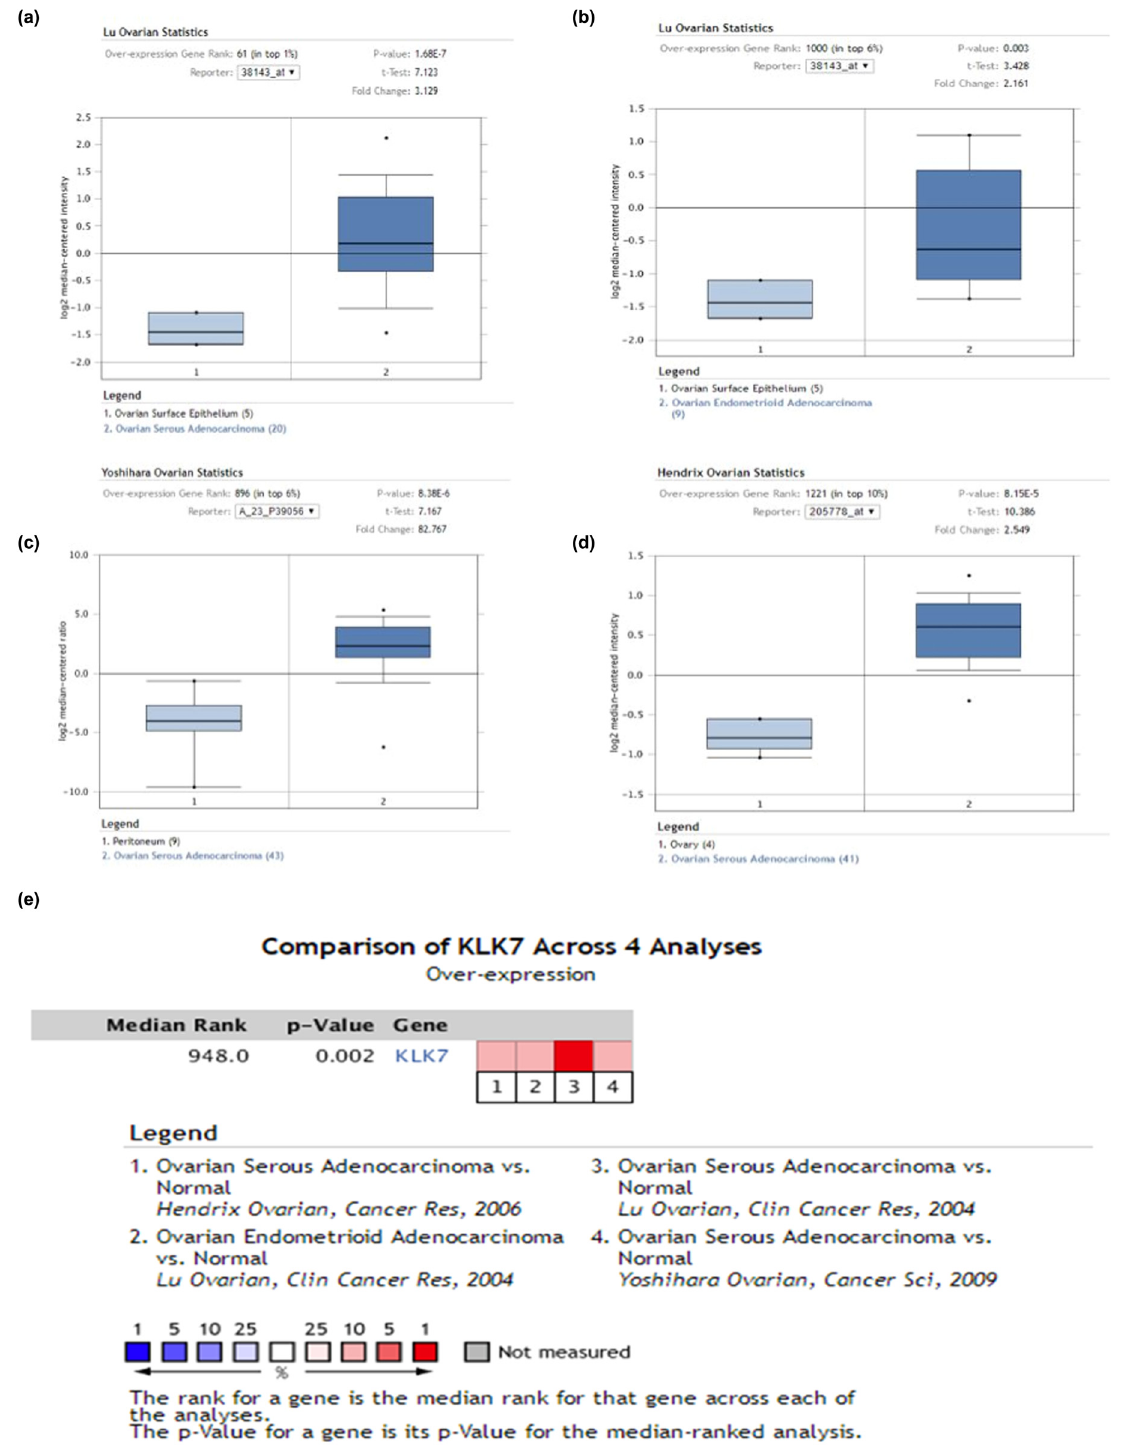
Figure 2: ( a – d ) Expression of KLK7 in in four various cancer data sets, ( e ) comparison of KLK7 across four